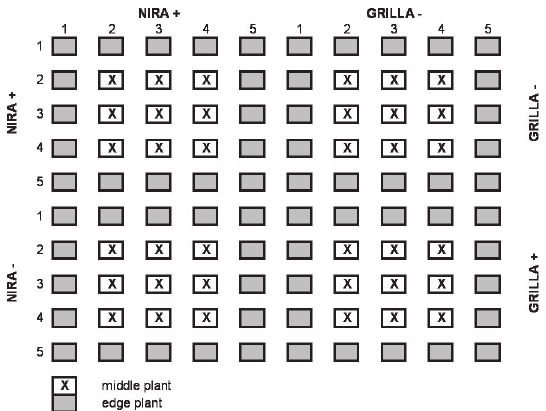
Fig 2. Example of a plot layout and the position of middle and edge plants.